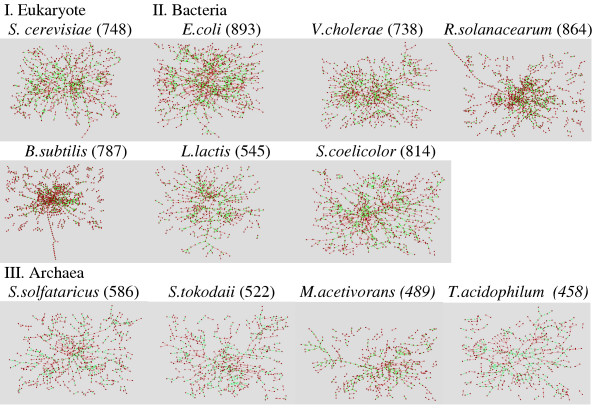
Visualizations of metabolic networks in the eleven organisms. In each graph, green lines represent arc and red lines represent edge. The numbers of distinct metabolites that are involved in at least one reaction are noted. All graphs are drawn with Pajek [33] using the layout optimization algorithm Kamada-Kawai.